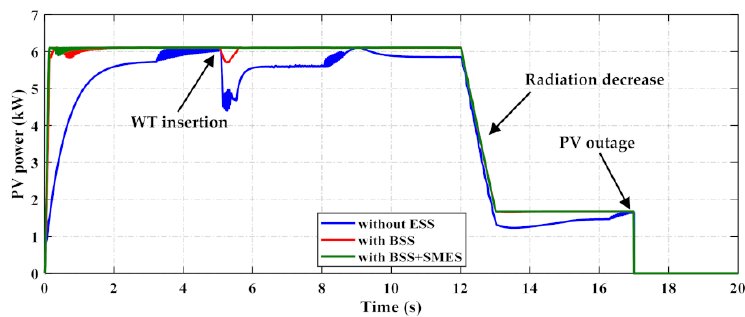
Figure 11. PV power during the three examined